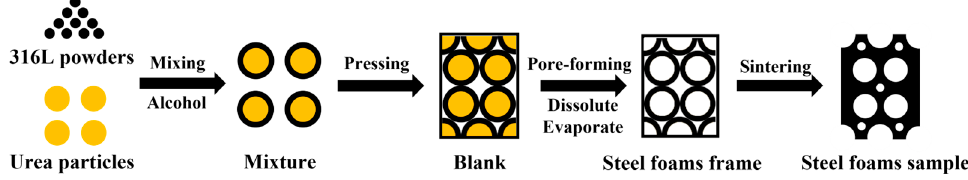
Figure 2. Process flow diagram for making steel foam.